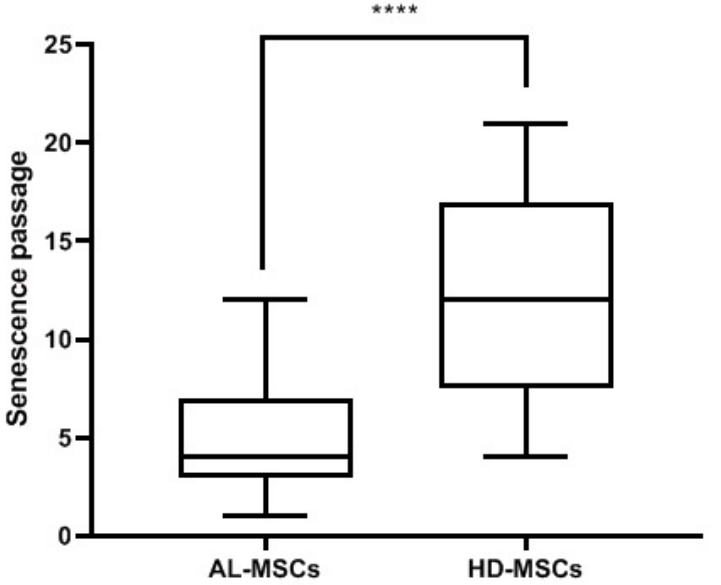
Figure 4. Senescence passages of AL- and HD-MSCs. Medians of the results [25–75%, Min-Max] are reported. **** p < 0.0001 .